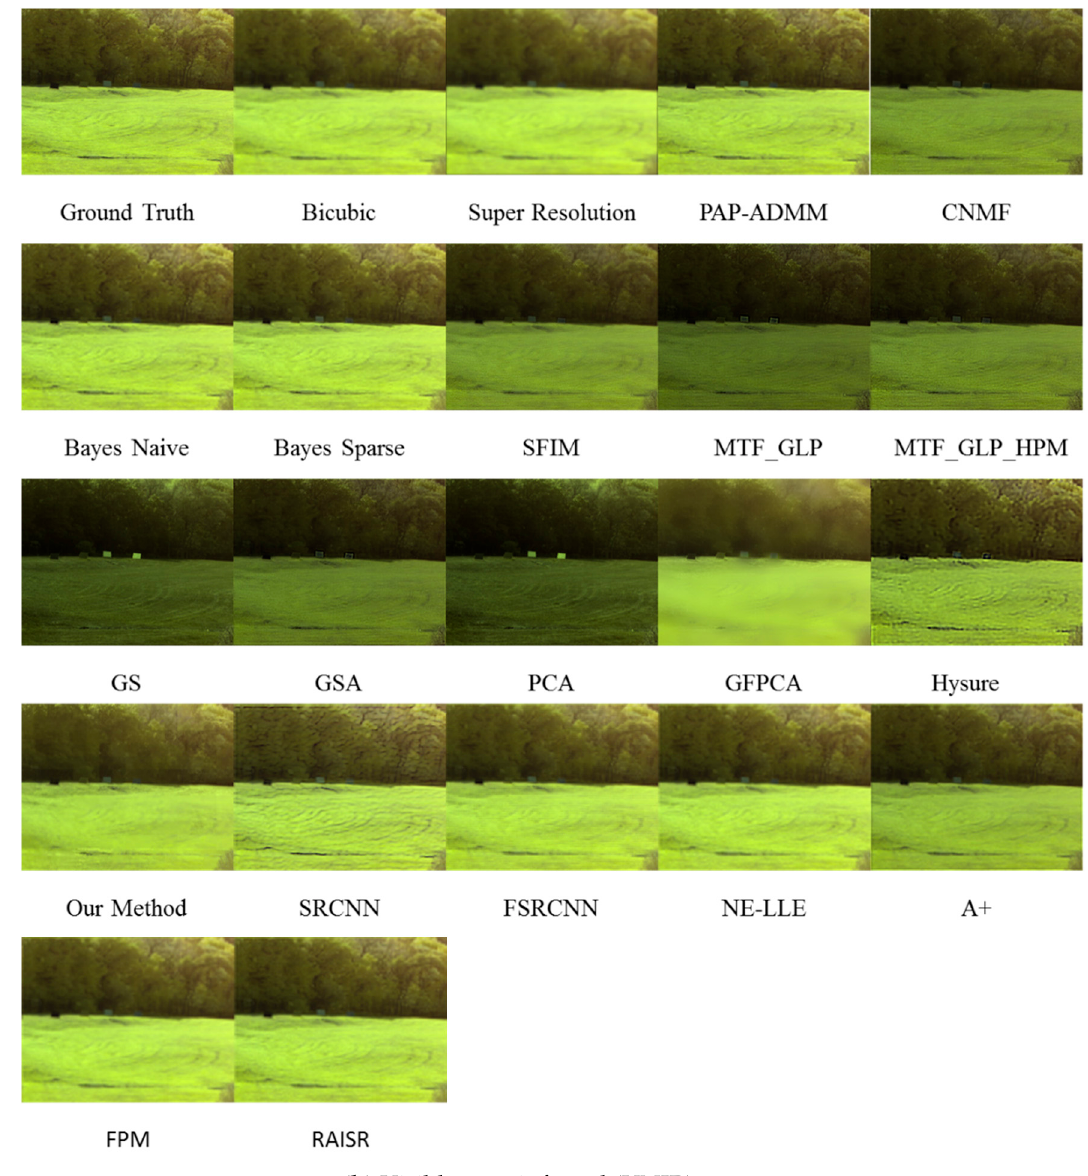
Figure 8. Fused AF images using different methods. ( a ) Visible range and ( b ) VNIR range.